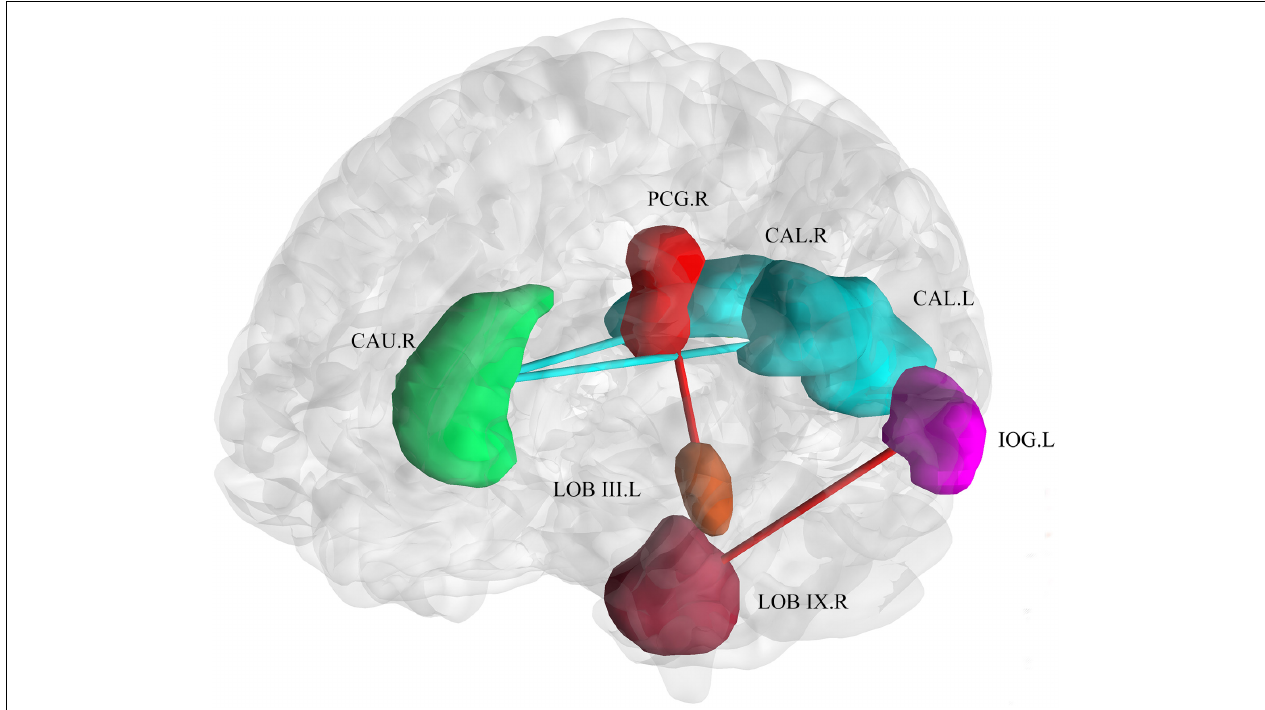
FIGURE 5 | Correlation of connectivity change with disease duration and age of onset. The plot shows that with an increase in duration or earlier age of onset, the functional connectivity strength between the bilateral calcarine and the right caudate decreased. The functional connectivity strength between the inferior occipital gyrus and right cerebellar lobule IX, and the right posterior cingulum gyrus and left cerebellar lobule III increased. Cold colors (blue and green) represent decreased functional connectivity. Warm colors (red and brown) represent increased functional connectivity. CAU.R, caudate nucleus; PCG.R, right posterior cingulum gyrus; CAL.R, right calcarine gyrus; CAL.L, left calcarine gyrus; IOG.L, left inferior occipital gyrus; LOB III. L, left cerebellar lobule III; LOB IX.R, right cerebellar lobule IX.